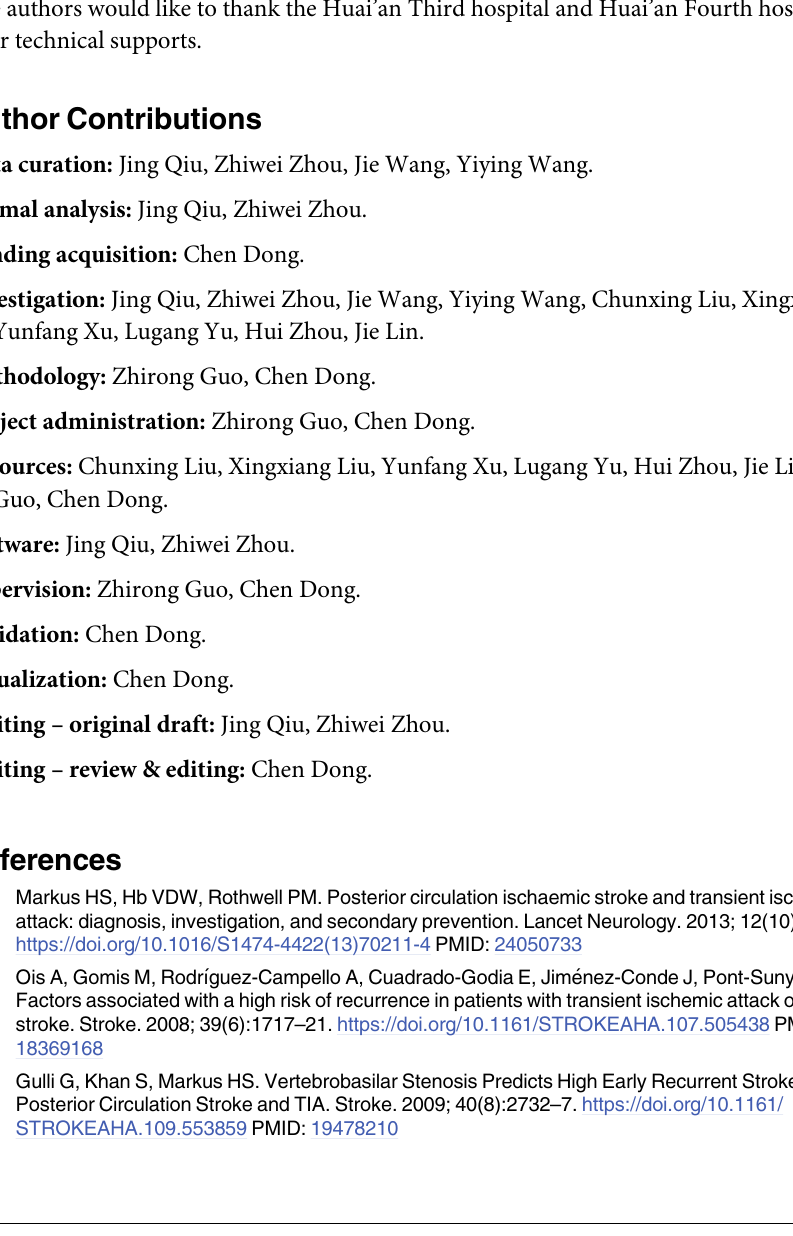
S2 Table. The original information of studied population for cross-sectional analysis. S3 Table. The original information of studied population for longitudinal